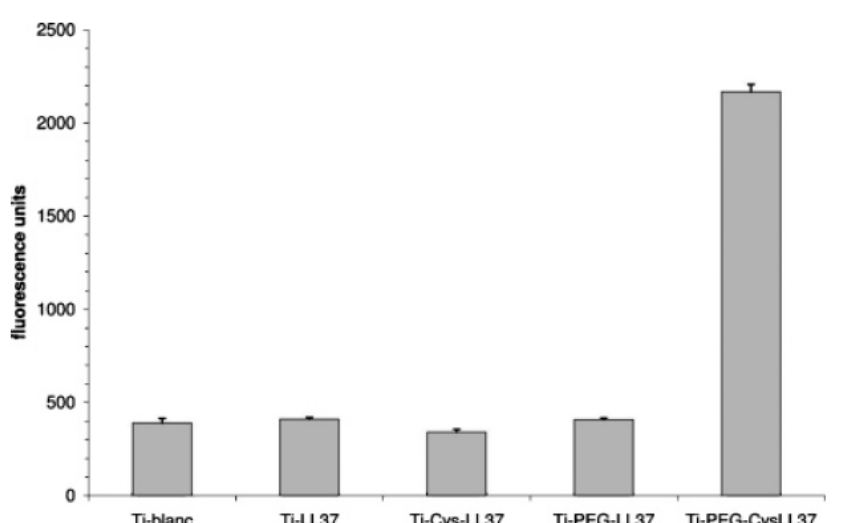
Figure 7. Fluorescence detection of bactericidal activity as a function of LL-37 AMP orientation and distance with respect to the surface. Reproduced with permission from [72]. Copyright 2006 American Chemical Society.